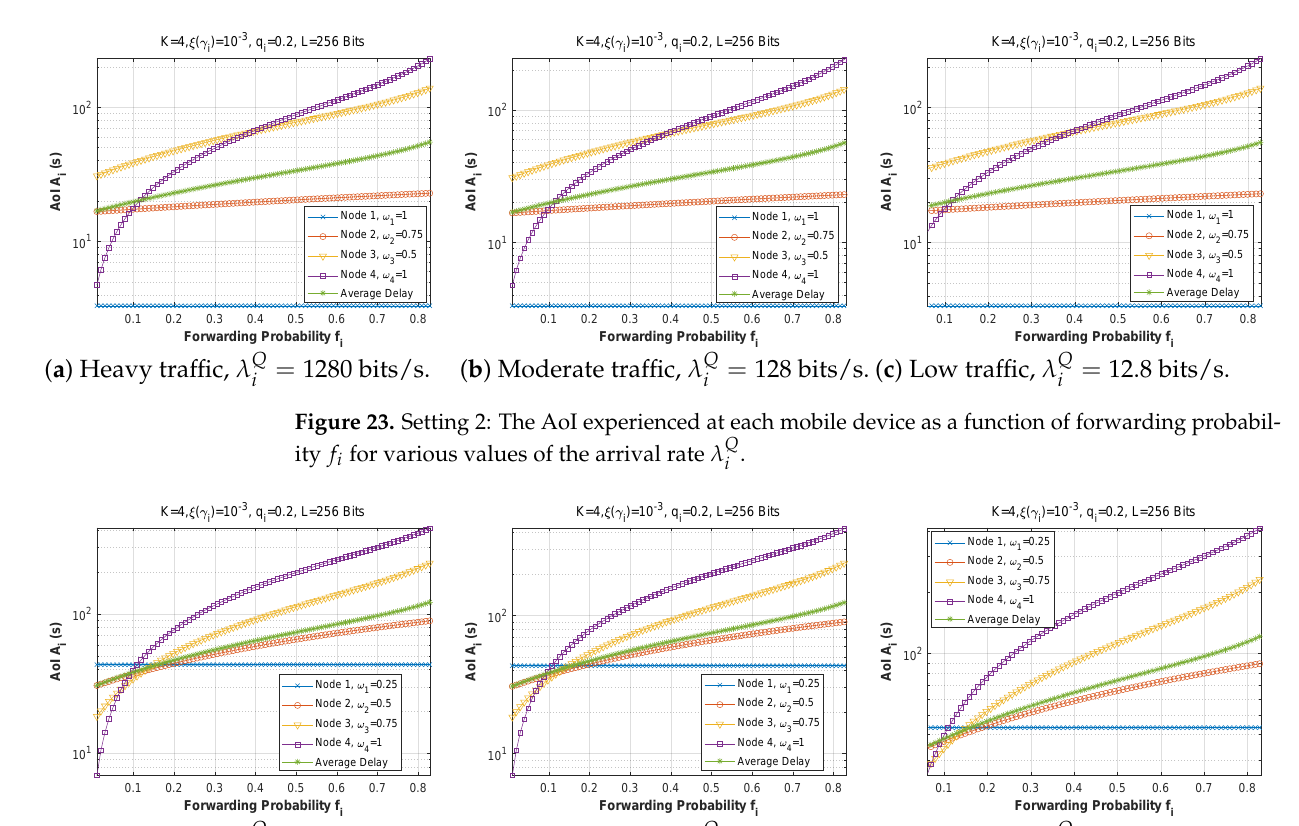
Figure 24. Setting 3: The AoI experienced at each mobile device as a function of forwarding probabil- ity f i for various values of the arrival rate λ Q